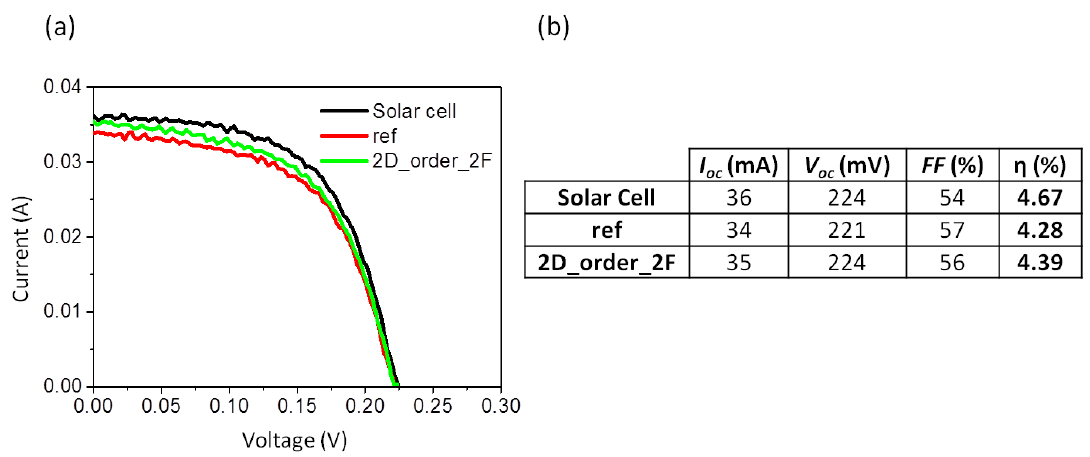
Figure 9. ( a ) I - V curves recorded for a solar cell with a conventional cover glass (ref), without cover glass (solar cell) and with a nanostructured cover glass (2D_ordered_2F) in a solar simulator. ( b ) Values of fill factor ( FF ) and solar efficiency ( η ) obtained from I - V curves.